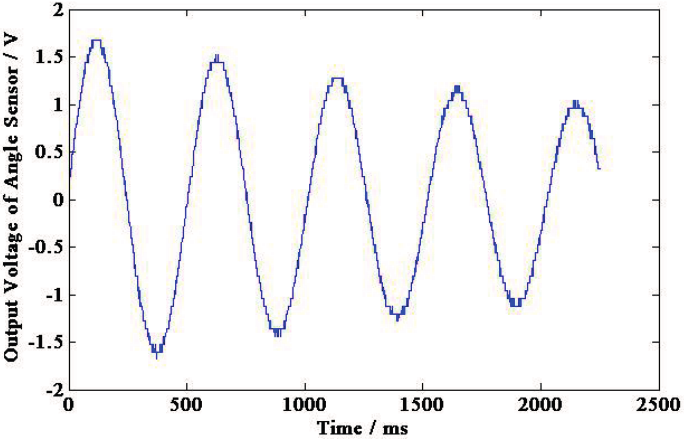
Figure 16. Induced voltage of the permanent magnetic angular acceleration sensor.